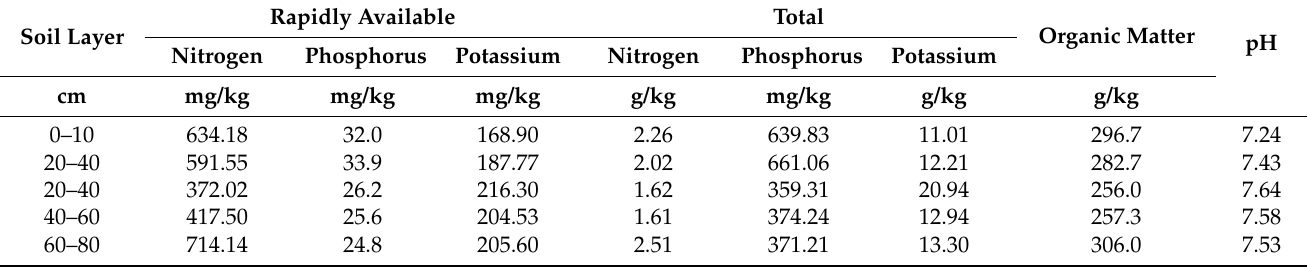
Figure 1. Precipitation during the 2016 and 2017 summer-maize growing seasons. Table 1. Physicochemical properties of soil.